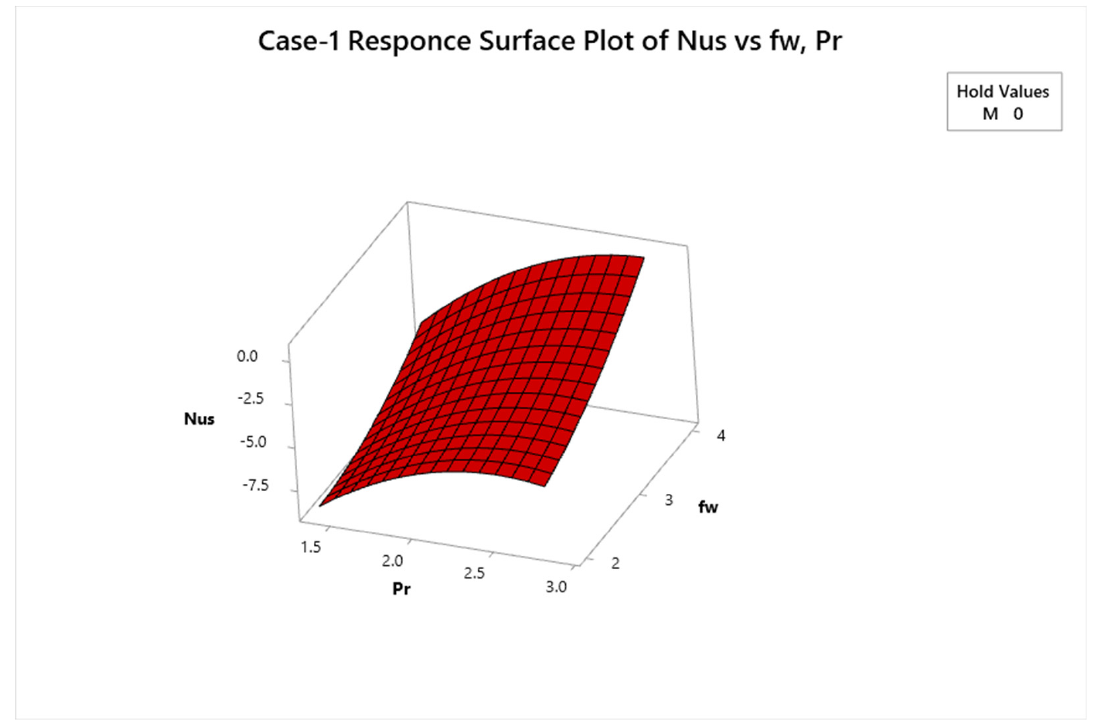
,Pr fw of Case-1. Figure 13. RSM plot for Nusselt number Vs fw ,Pr of Case-1.